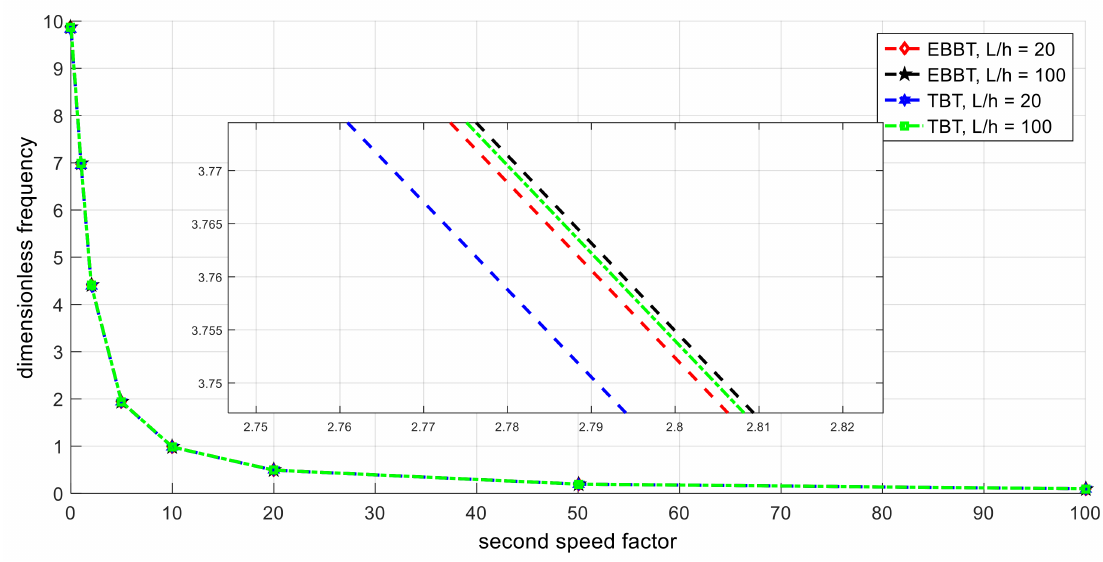
Figure 3. Variations of dimensionless fundamental frequency with lateral velocity (speed)